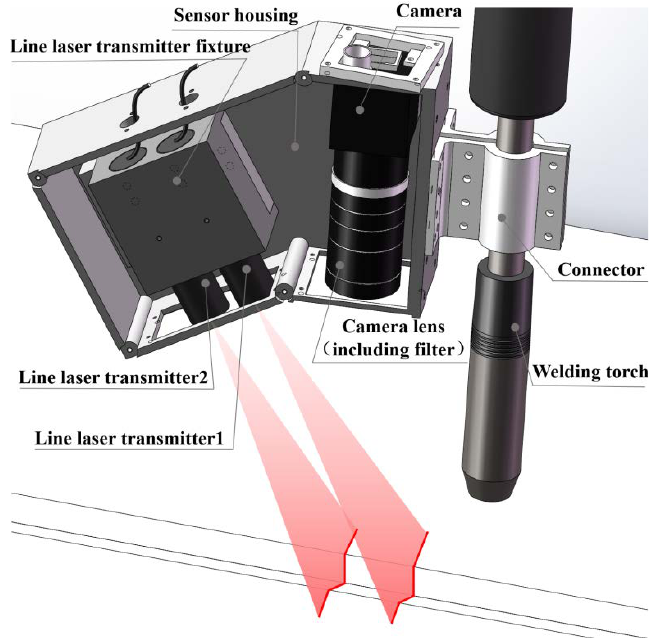
Figure 1. Schematic diagram of vision sensor based on combined laser structured lights. Table 1. Component selection and their main parameters of vision sensor.